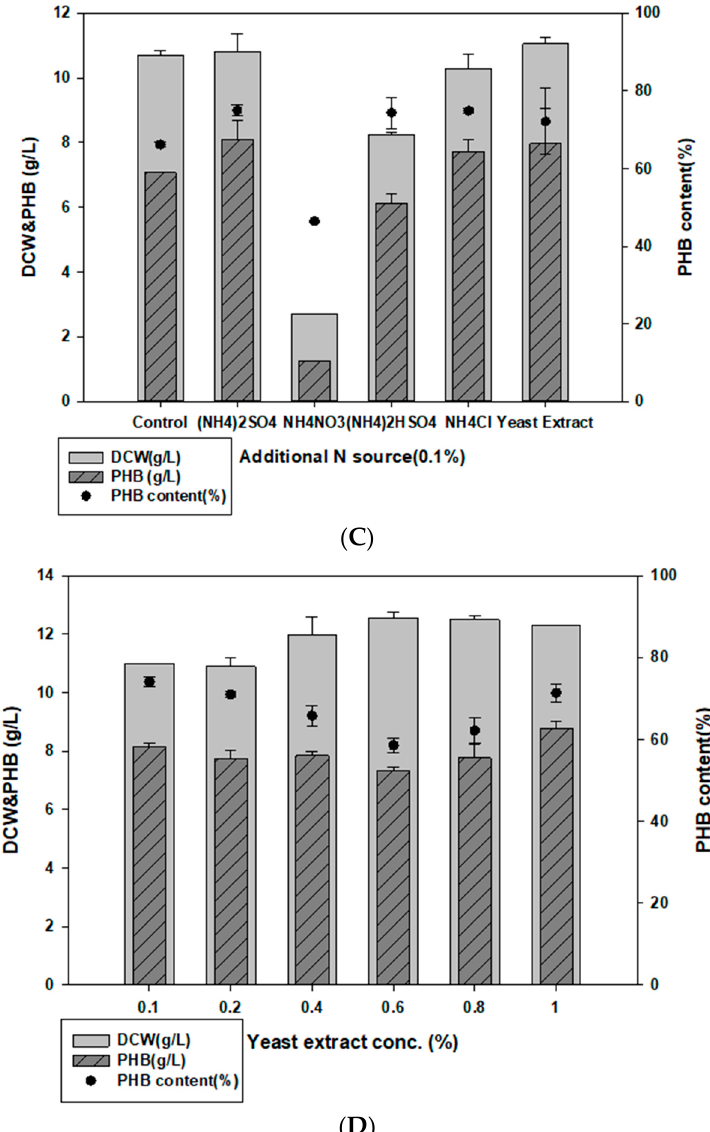
Figure 2. Optimized carbon and nitrogen sources for PHB production. ( A ) Comparison of PHB pro- duction in MB medium with 2% ( w / v ) additional carbon sources. ( B ) Effect of galactose concentration on PHB production. ( C ) Comparison of PHB production in MB medium with 0.1% ( w / v ) additional nitrogen sources. ( D ) Effect of yeast extract concentration on PHB production in MB.